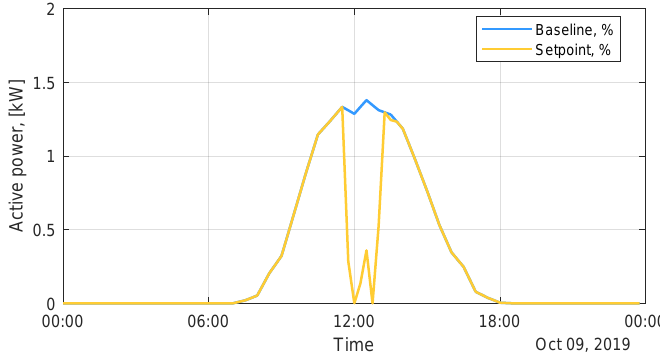
Figure 23. Control action. Generator connected to node 27